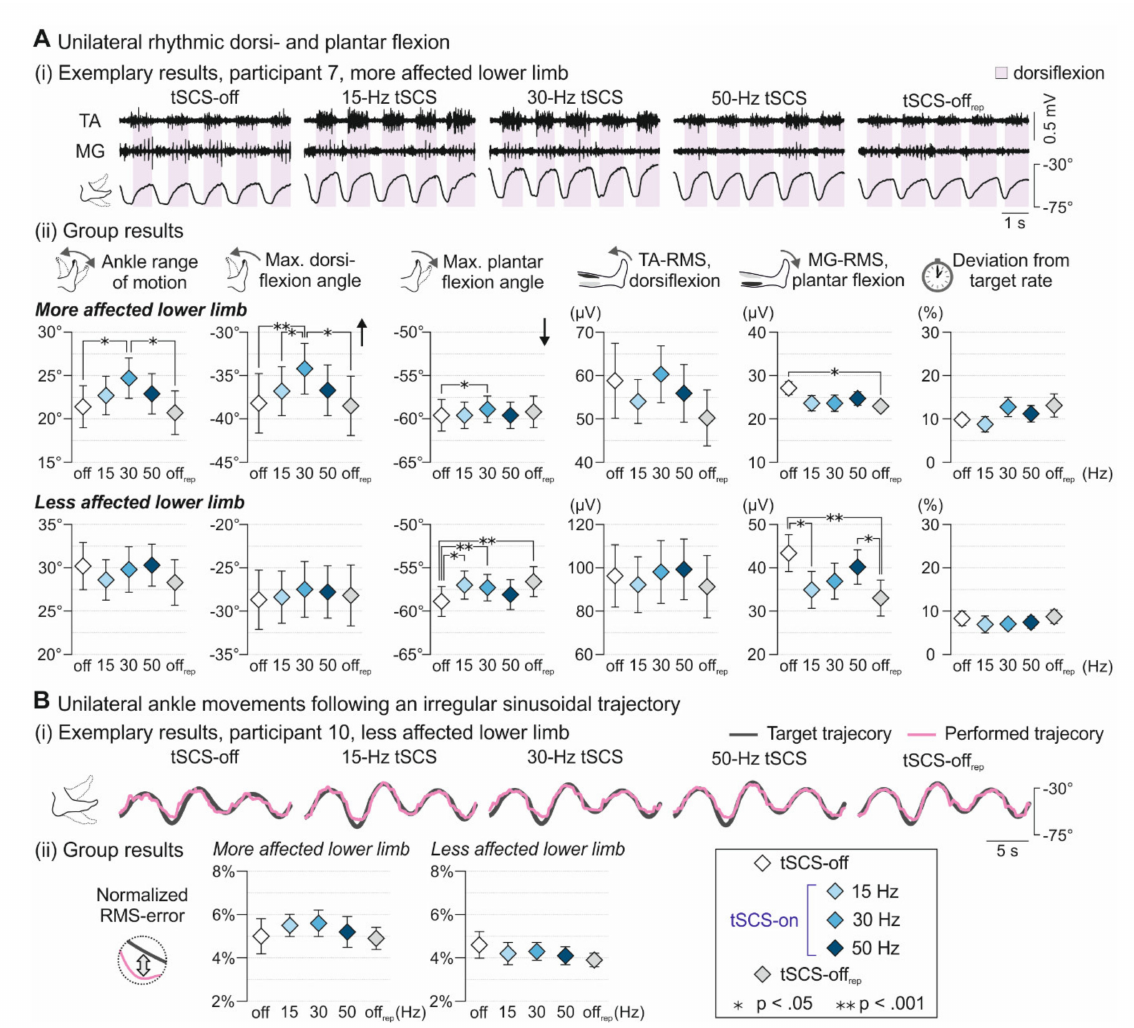
Figure 1. E ff ect of tSCS on voluntary unilateral ankle control. ( A ) Unilateral rhythmic dorsi- and plantar flexion movements. ( i ) EMG activities of tibialis anterior (TA) and medial gastrocnemius (MG) shown for five movement cycles at a rate of 1.6 Hz during tSCS-o ff , tSCS at stimulation frequencies as indicated, and tSCS-o ff rep for the more a ff ected lower limb of participant 7. Shaded backgrounds mark dorsiflexion phases, identified based on kinematic data. Under tonic tSCS, maximum ankle angles and TA activity during dorsiflexion were increased, while clonus-like activity in MG that was present in the tSCS-o ff condition was visibly reduced. ( ii ) Group results (mean ± SE) across movement rates of ankle range of movement; maximum dorsiflexion angles (black arrow indicates direction of dorsiflexion, zero reference represents an absolute joint angle of 90 ◦ , i.e., as during an upright standing position); maximum plantar flexion angles (black arrow indicates direction of plantar flexion); TA EMG-RMS values during dorsiflexion; MG EMG-RMS values during plantar flexion; and deviation from target movement rate during tSCS conditions as indicated, separately shown for the more and the less a ff ected lower limbs. ( B ) Unilateral ankle movements following an irregular sinusoidal target trajectory. ( i ) Exemplary recordings of performed ankle movements (purple line) relative to the predefined irregular target trajectory (grey line); less a ff ected lower limb, participant 10. ( ii ) Group results (mean ± SE) of the normalized RMS-error, providing information on the deviation of the performed movement from the target trajectory, across tSCS conditions, shown for the more and the less a ff ected lower limb. Asterisks mark significant results of post-hoc pairwise comparisons. deg., degree; EMG, electromyographic; MG, medial gastrocnemius; RMS, root mean square; TA, tibialis anterior; * p < 0.05; ** p <